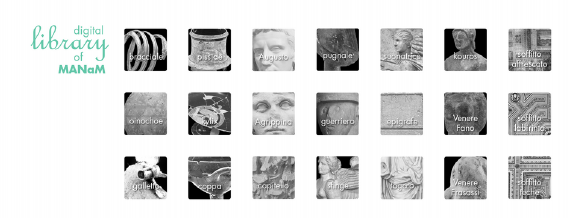
Figure 7. Home page of Digital Library in the VISUAL